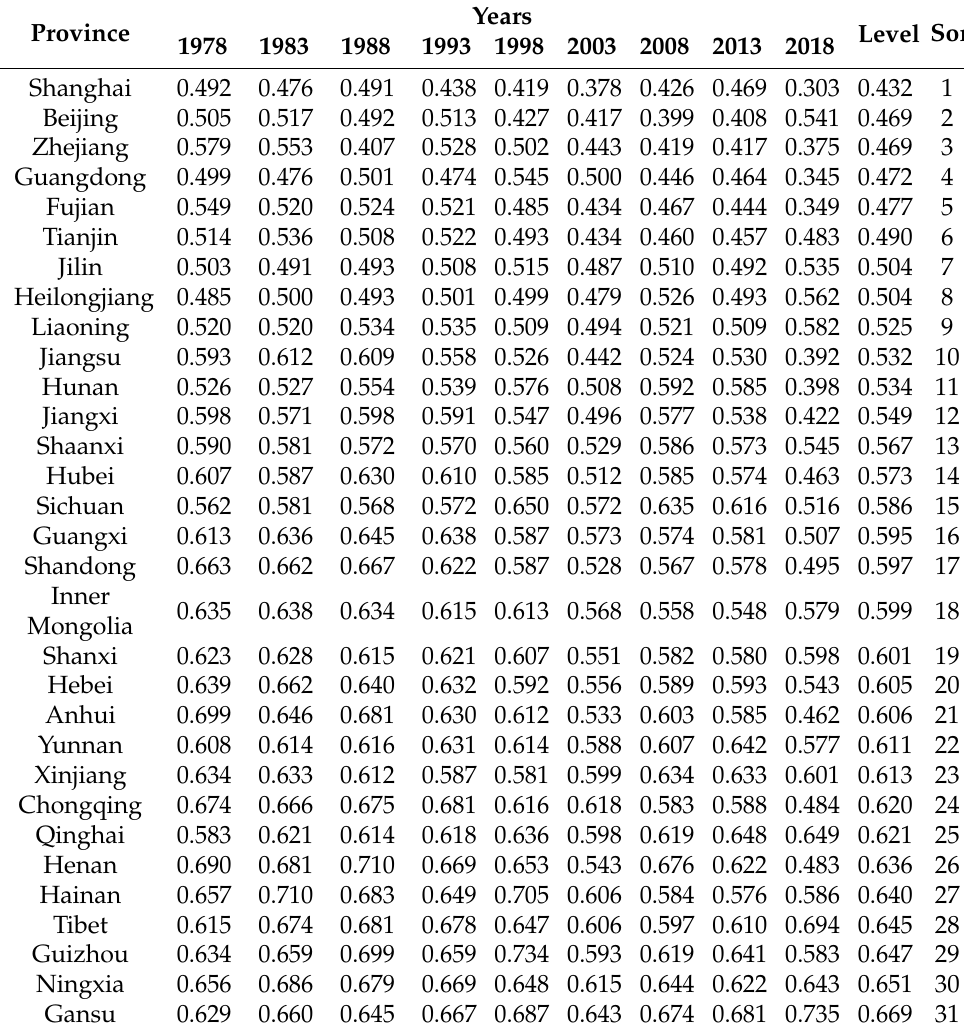
Table 4. Vulnerability of agricultural drought in different